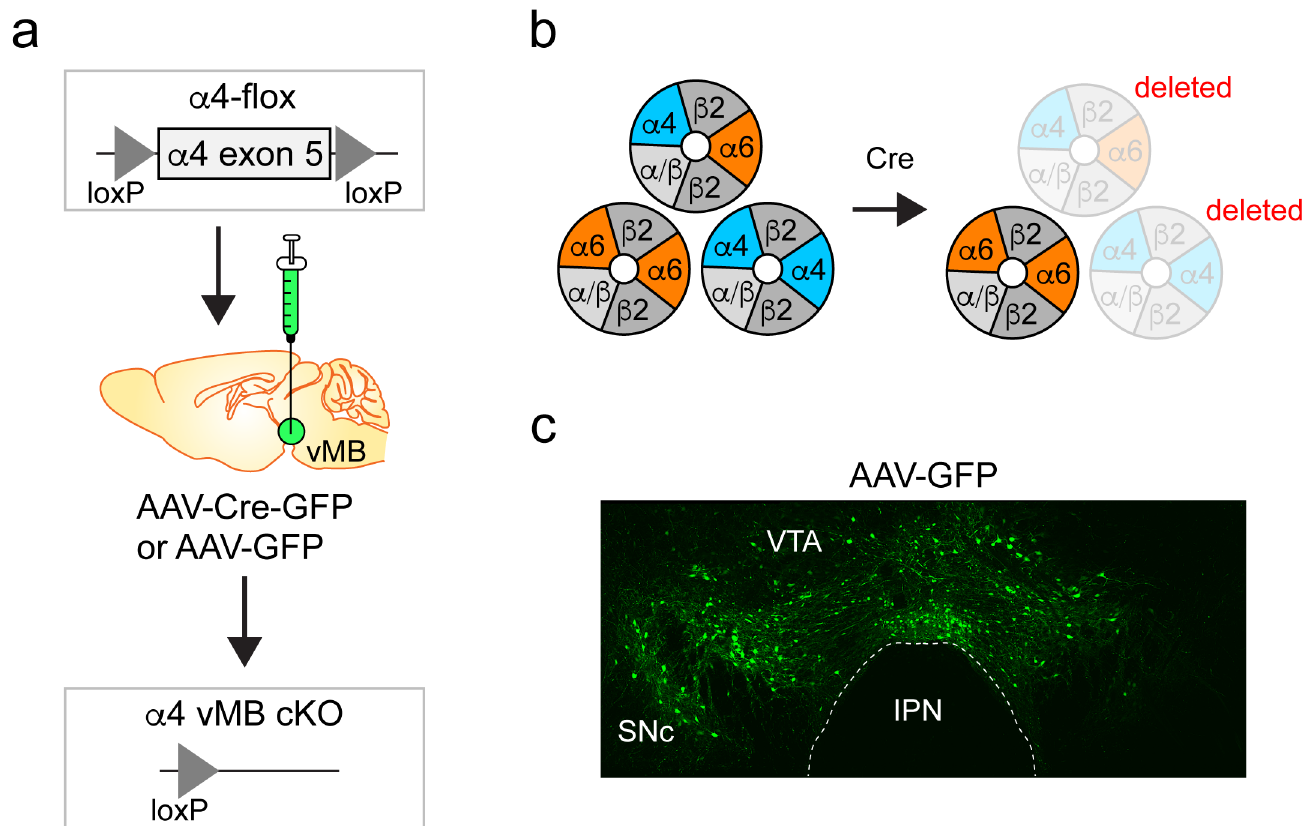
Fig 1. Conditional KO of α 4 nAChR subunits. a) α 4-flox mice have loxP sites flankingexon 5 of the α 4 nAChR gene. Infusion of viral vectors expressingCre recombinase into the VTA results in conditional deletionof α 4 in infected cells. b) The three main heteromericnAChR subtypes found in neuronsof the midbrain DA system, α 4 α 6 β 2 * , α 6 β 2(non- α 4) * , and α 4 β 2(non- α 6) * , are shown. Deletionof α 4 eliminates α 4 α 6 β 2 * and α 4 β 2(non- α 6) * subtypes, whileisolatingthe activity of α 6 β 2(non- α 4) * nAChRs. c) Viral spreadof AAV-GFP vectors. An AAV-GFP virus was infused bilaterallyinto the VTA of a C57BL/6WT mouse, followed3 weeks later by perfusionand anti-GFP stainingof brain sections.